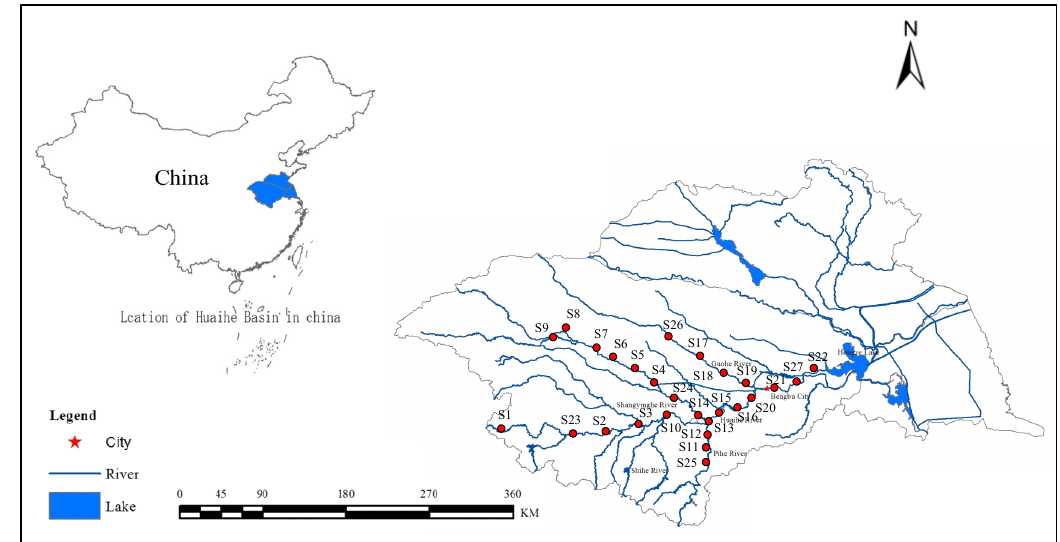
Figure 1. Location of study area, distribution of the sampling sites for the benthic community and environmental variables in the mainstream and other three important tributaries of the Huai River basin (HRB).